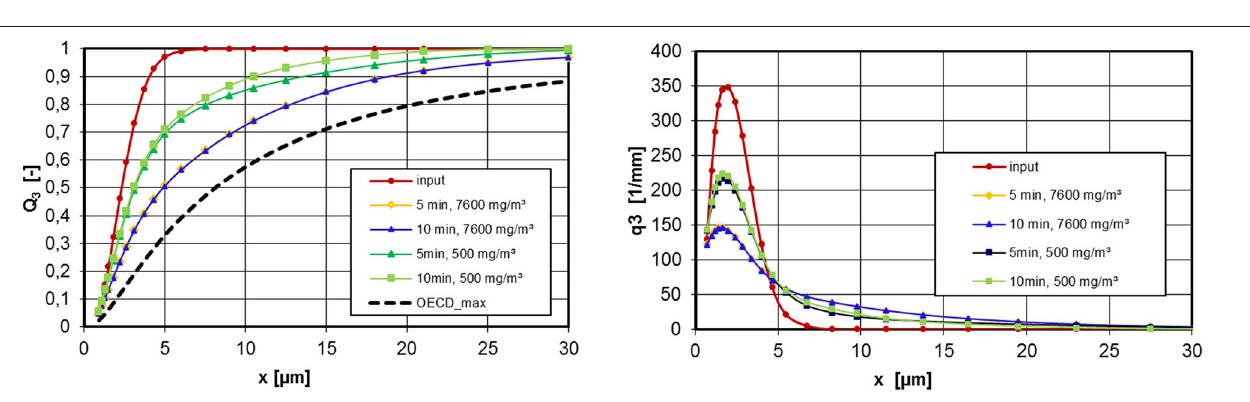
FIGURE 11 | PSD at the inlet and exhaust tube of the inhalation chamber for different operating times, silica gel, ρ eff = 242 kg/m 3 , left: c m = 7,600 mg/m 3 and 500 mg/m 3 , right: volume density distributions.